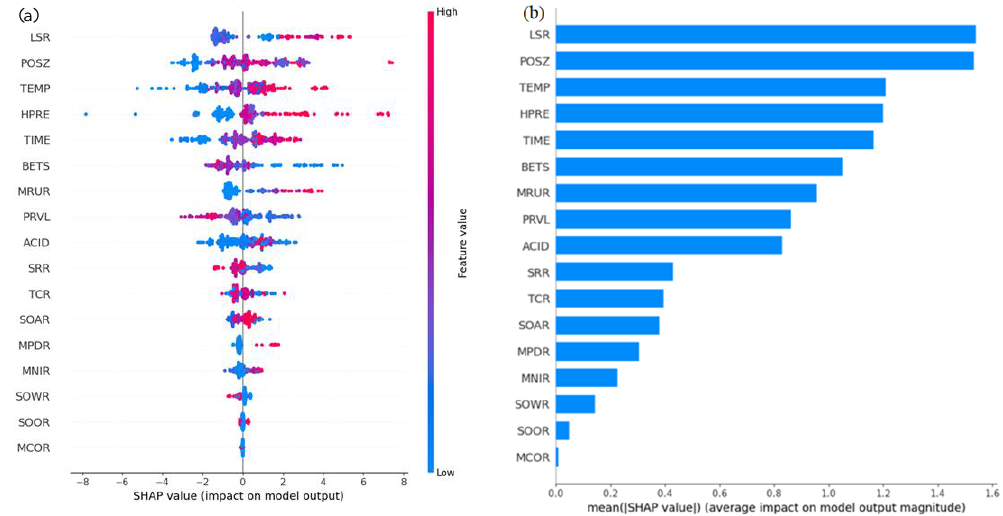
Figure 5. SHAP value (a) and feature importance (b) of XgBoost prediction on aromatics.